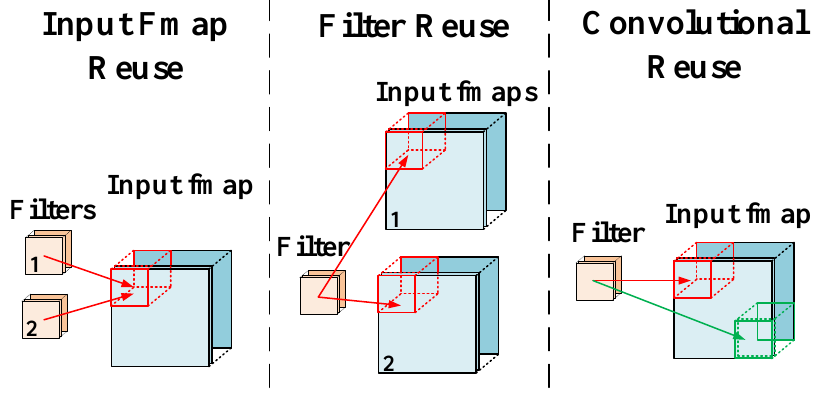
Figure 11. Common data reuse modes.